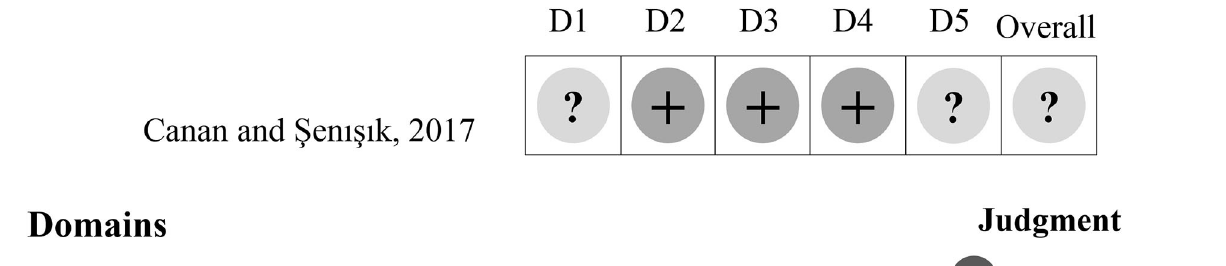
between first and second premolars, and between